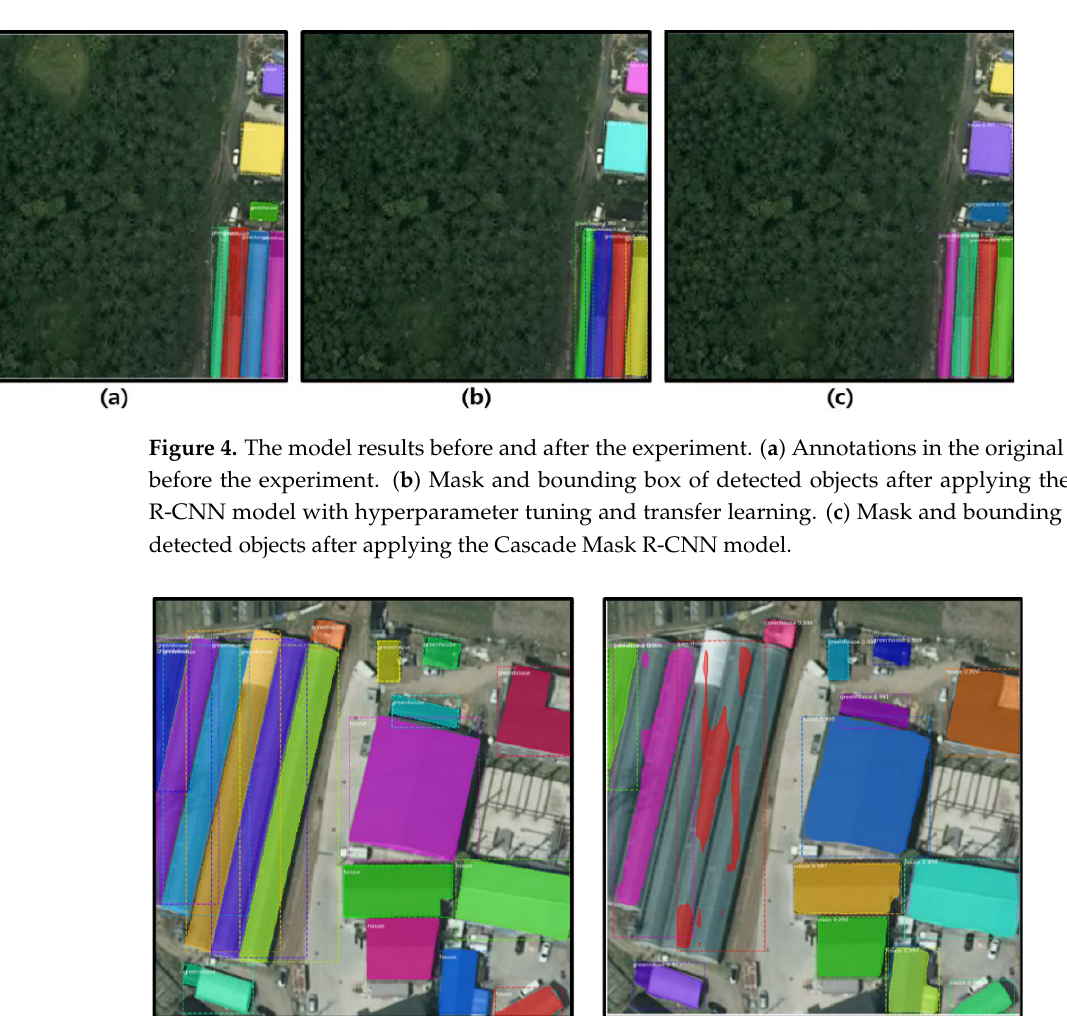
Figure 4. The model results before and after the experiment. ( a ) Annotations in the original image before the experiment. ( b ) Mask and bounding box of detected objects after applying the mask R- CNN model with hyperparameter tuning and transfer learning. ( c ) Mask and bounding box of de- tected objects after applying the Cascade Mask R-CNN model.